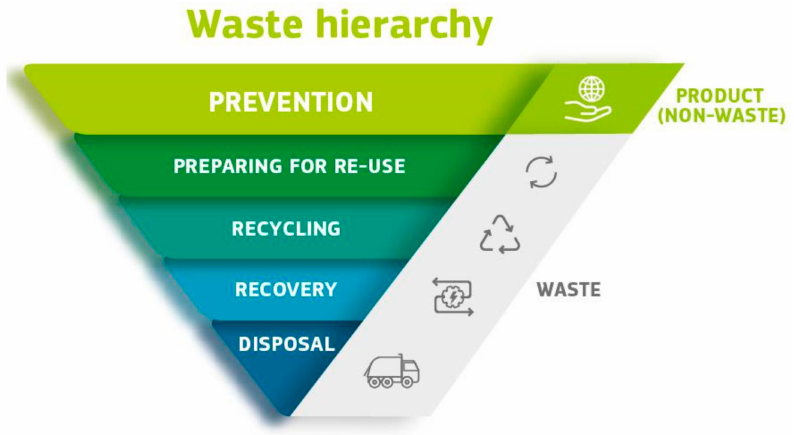
Figure 1. Waste hierarchy in